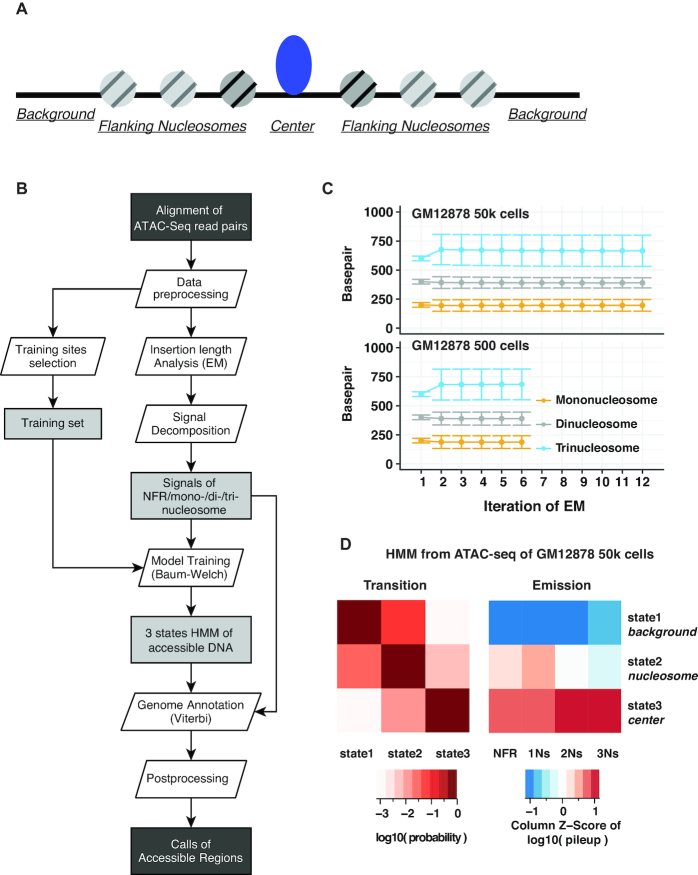
The HMMRATAC Algorithm. (A) A schematic to represent the structure of an accessible region. (B) The algorithmic workflow. (C) Estimation of fragment length parameters through the Expectation-Maximization algorithm. Mean and standard deviation parameters per EM iteration for three nucleosomal distributions are consistent among datasets using 50 000 and 500 cells. The parameters for NFR signals are fixed during EM training so they were not plotted. Iteration #1 shows the initial parameters. EM was applied to pooled biological replicates. The parameters per biological replicate were shown in Supplemental Figure S3. (D) The transition and emission parameters of the Hidden Markov Model trained through the Baum-Welch algorithm on the 50 000 GM12878 cells ATAC-seq data.